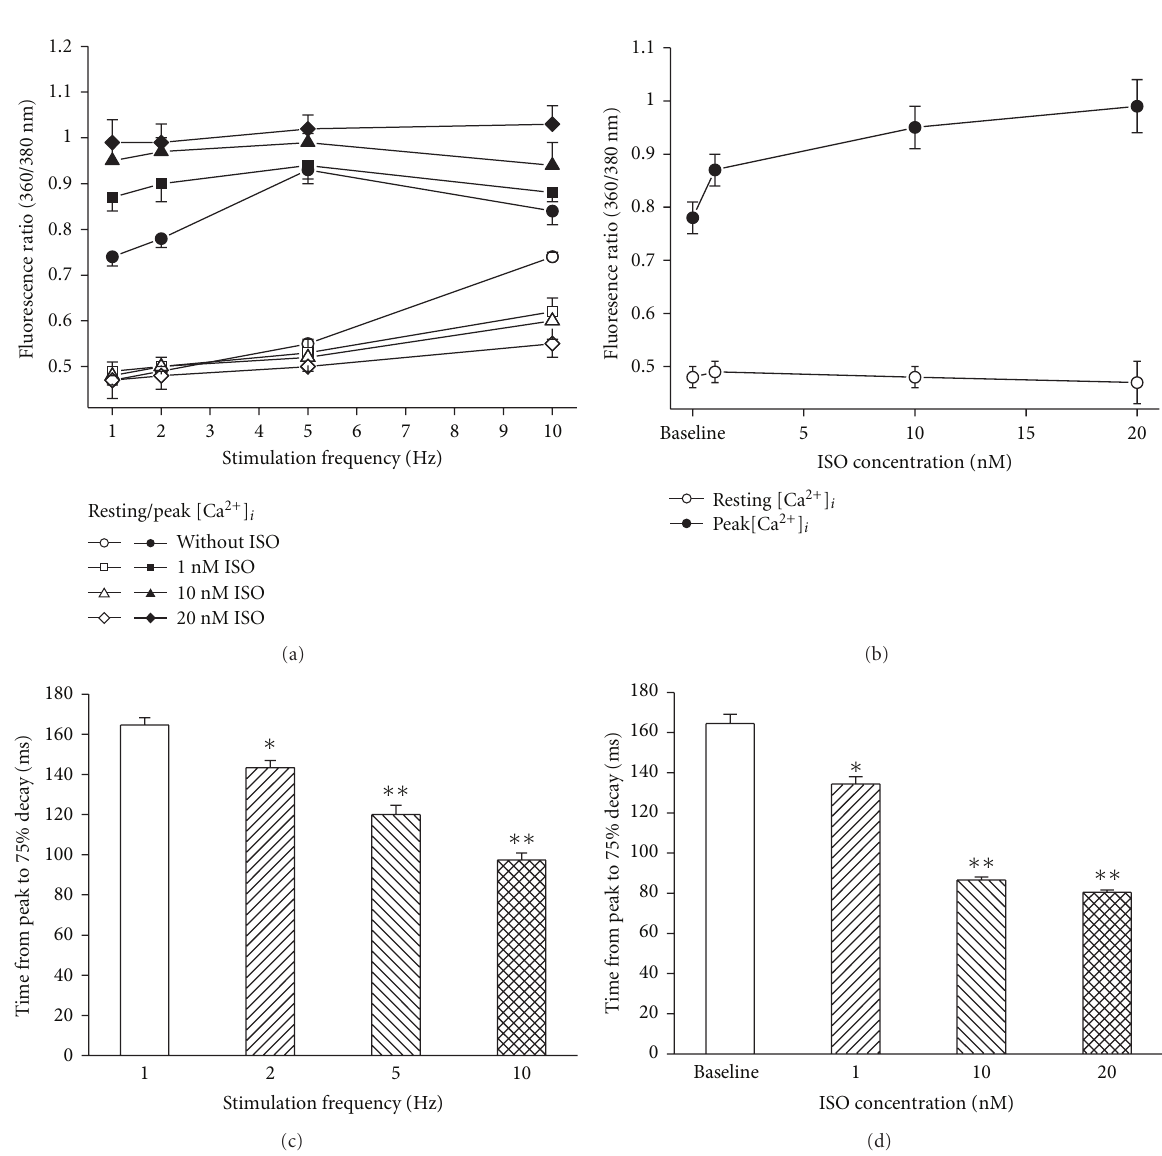
indicate that phosphorylation of cTnI by PKA may be partic- ularly important in modulating diastolic function of